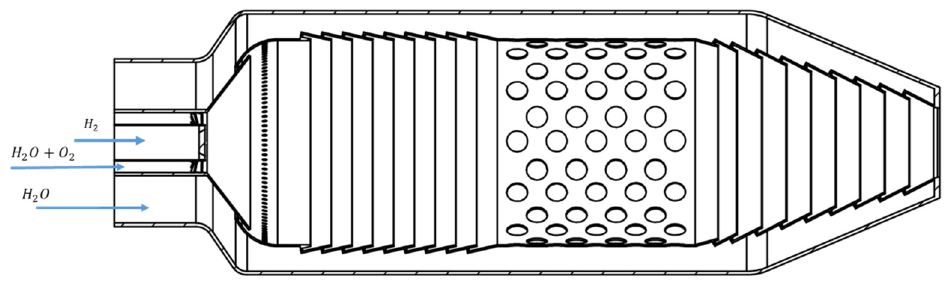
Figure 2. Straight-flow hydrogen-oxygen combustion chamber. Adjustment of temperature and flame propagation rate is carried out by changing the fraction of water vapor γ , Equation (1), within a wide range